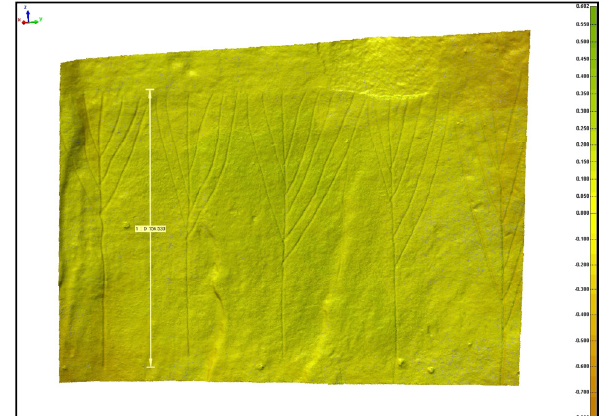
Figure 11. Close-range recording of Viking runic inscriptions inside Maeshowe chambered tomb using a Perception Scanworks v5 laser scanner © Crown Copyright 2010.